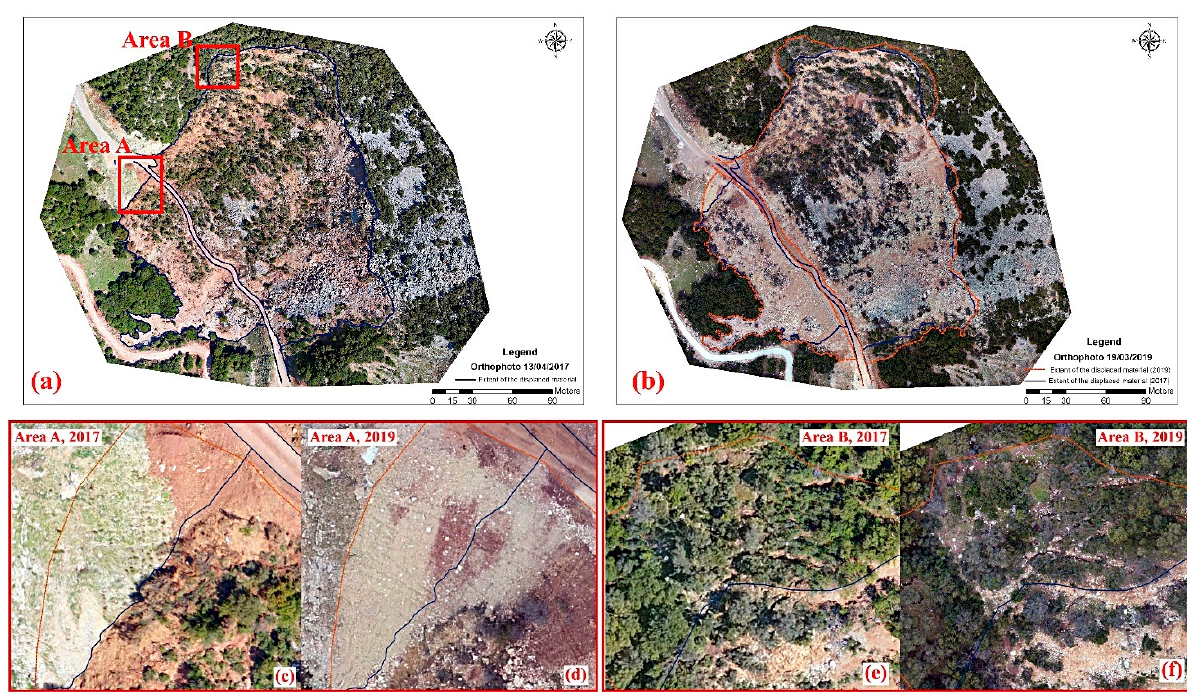
Figure 14. The evolution of the extent of the landslide between 2017 and 2019. ( a ) The landslide boundaries in 2017. ( b ) The landslide boundaries in 2019. ( c , d ) The evolution of the extent of the landslide between 2017 and 2019 in area A. ( e , f ) The evolution of the extent of the landslide between 2017 and 2019 in area B.